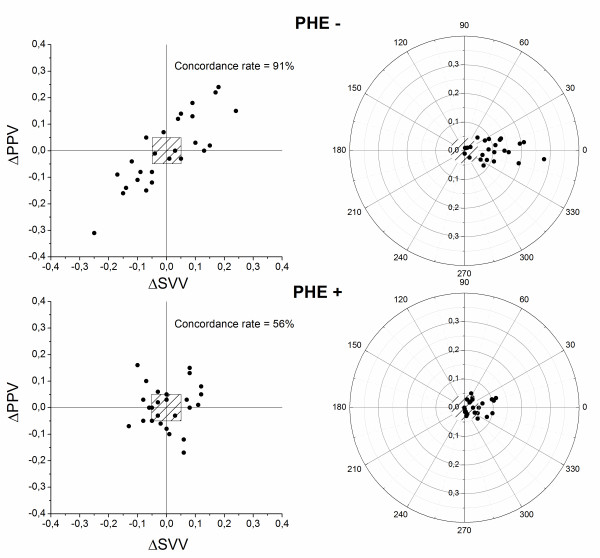
The four-quadrant plots and polar plots to examine the trending abilities of PPV against SVV under normal vasomotor tone (PHE-) and under increase vasomotor tone (PHE+). Half-circle polar plots are shown with data transformed to positive directional data only. We applied an exclusion zone when the percentage of change of data was below 15% (0.5). SVV: stroke volume variation, PPV: pulse pressure variation.